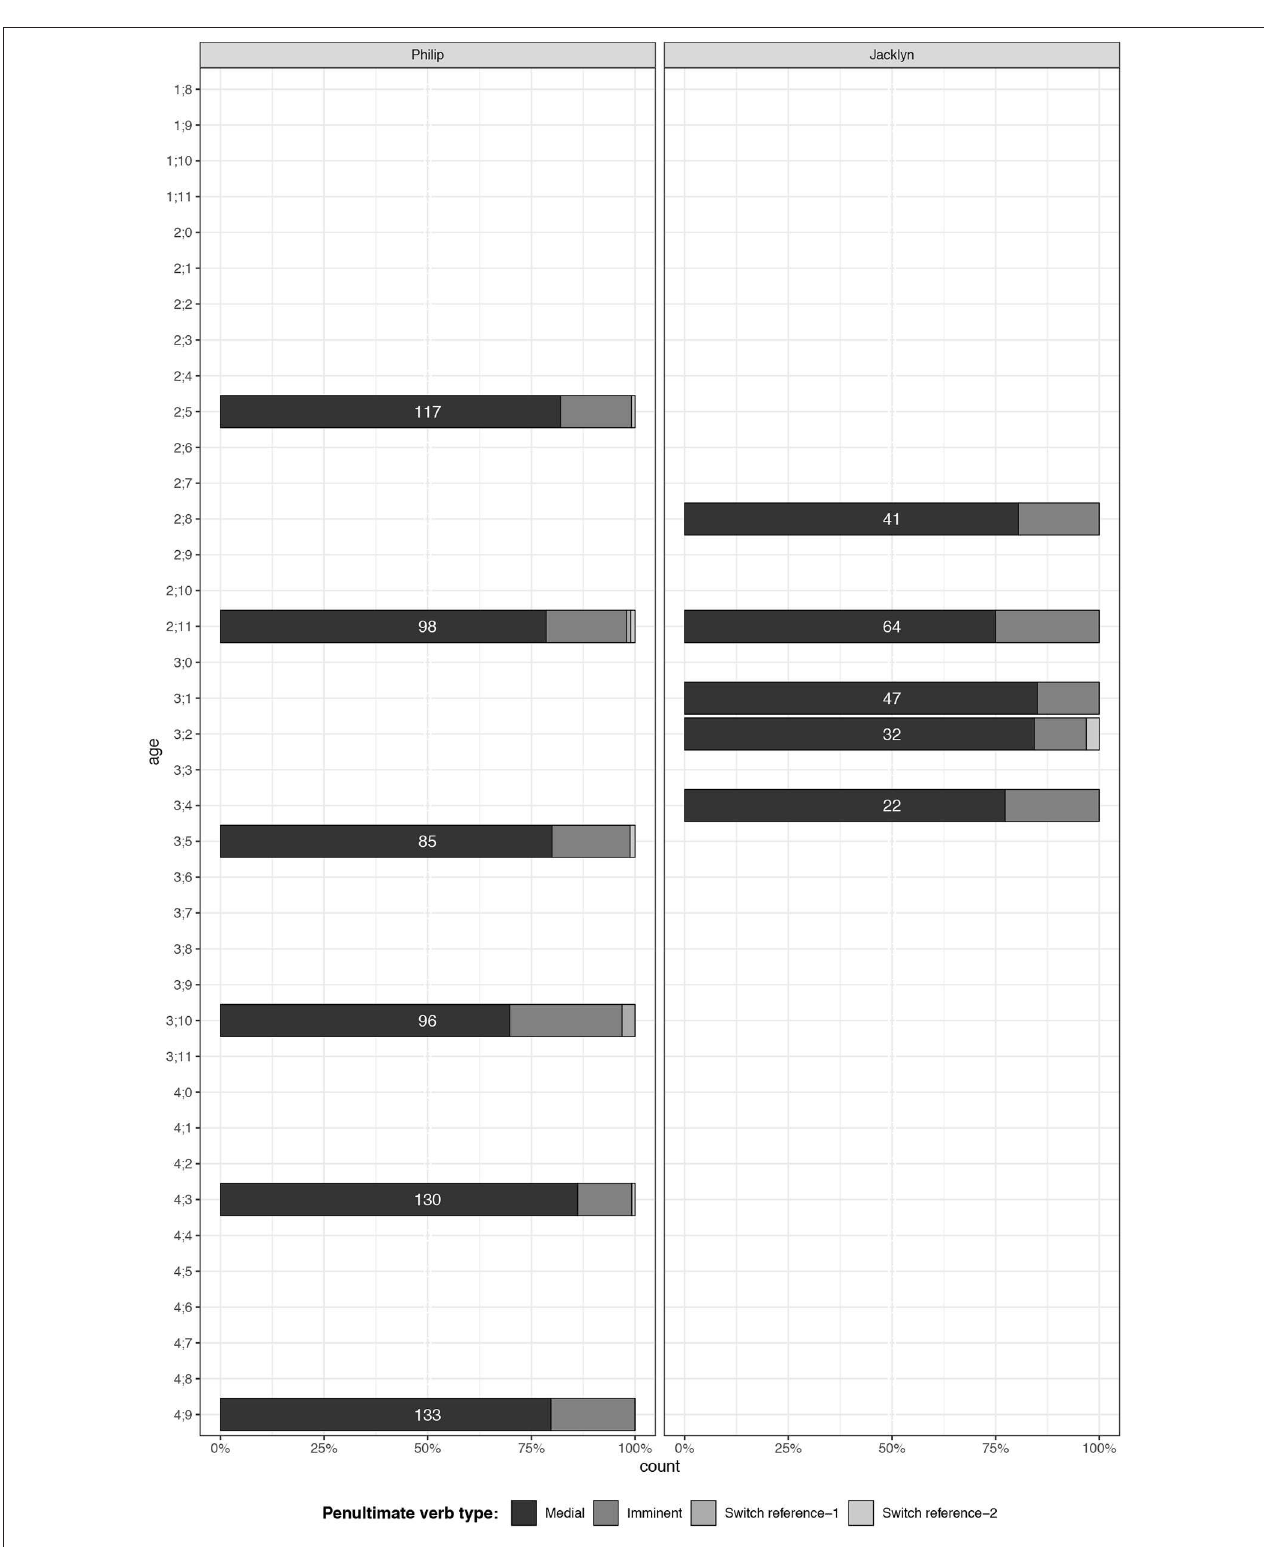
FIGURE 9 | Proportions of verb types in the second-to-last clauses in speech of adults to Philip and Jacklyn.